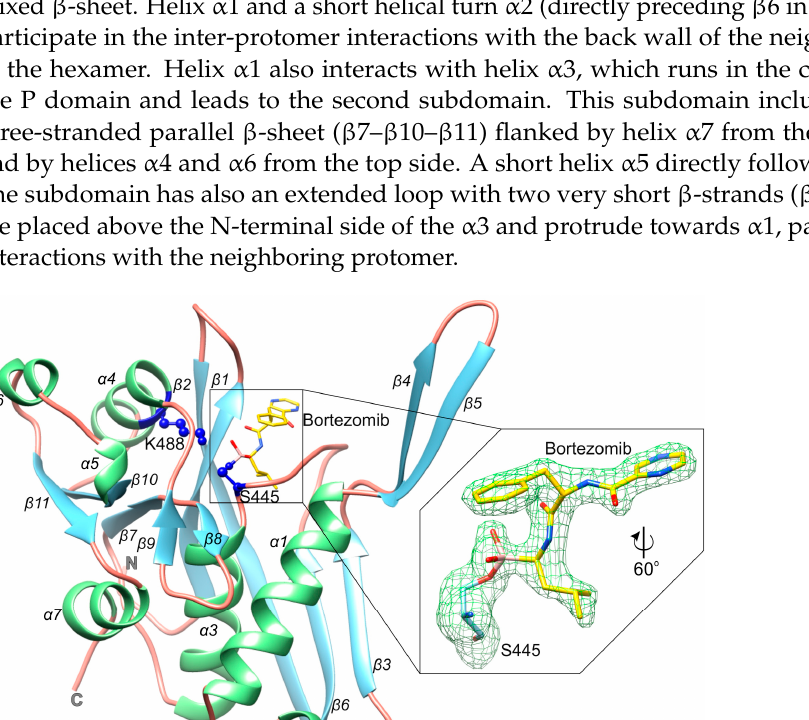
charged groups ~3.4 Å (Figures 4 and 5). Here, the chamber widens to ~16.5 Å .